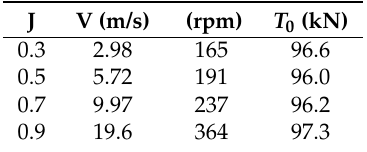
Table 2. Flow conditions for steady flexible propeller